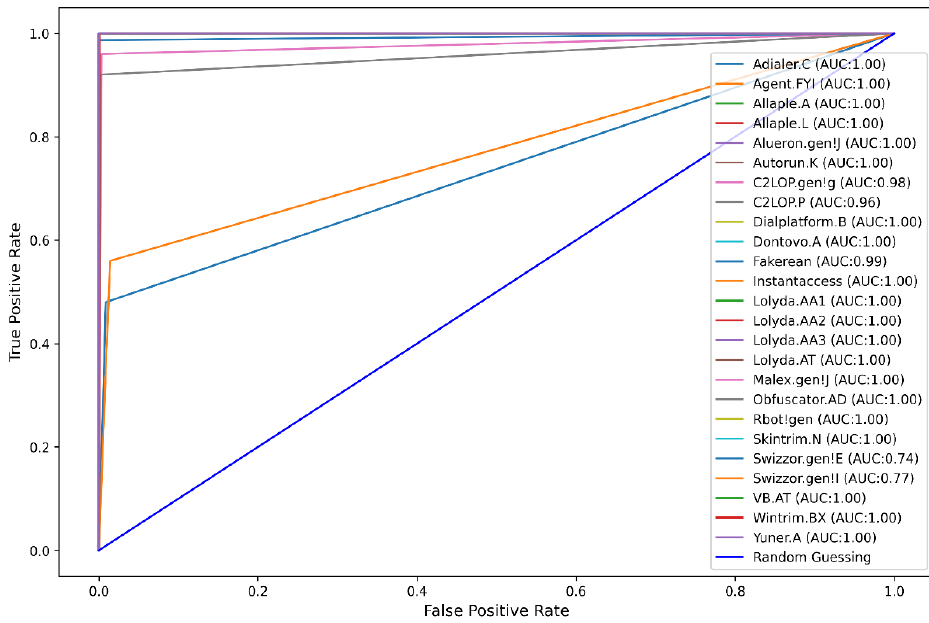
Figure 13. ROC (receiver operating characteristic) curves with area under curve values for classification into 25 malware families.